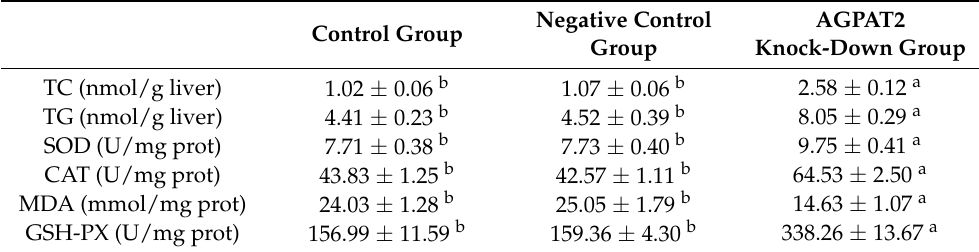
Table 4. Liver indexes for control, negative control, and AGPAT2 knock-down